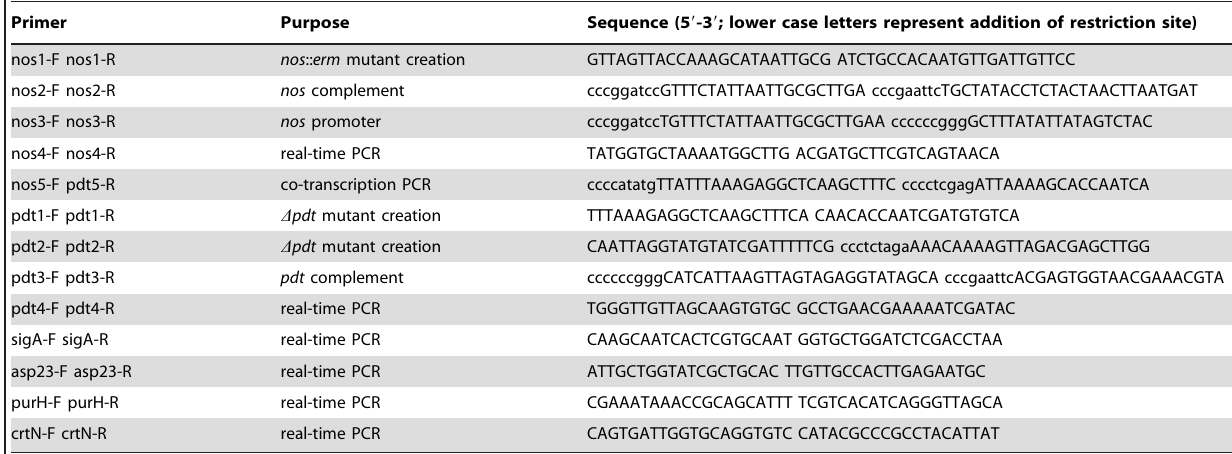
Table 2. PCR primers used in this